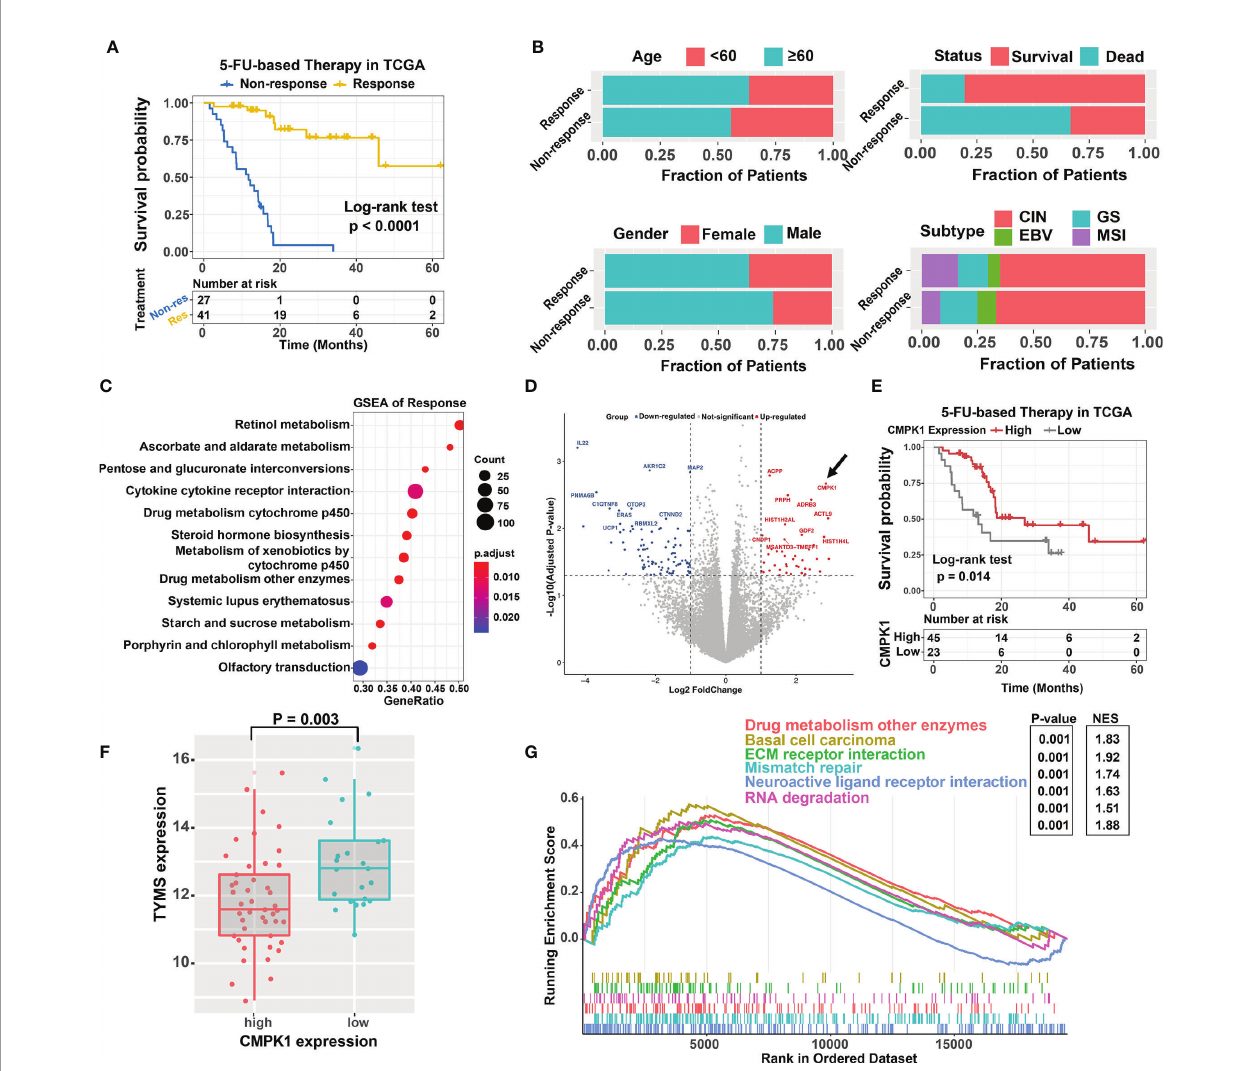
FIGURE 1 | Identi fi cation of the CMPK1 affect the 5-FU chemosensitivity. (A) Kaplan-Meier survival curves of progression-free survival (PFS) for 68 GC patients with 5-FU-based-chemotherapy response (yellow line) or non-response (blue line). (B) Association of clinical features (age, gender, survival status, molecular subtype) and treatment response in GC samples. (C) Dysregulation of signaling pathways strati fi ed by response versus non-response subtypes. (D) volcano plot of the differentially expressed genes in different treatment response subtypes. Blue and red dot indicated the genes highly expressed in non-response and response subgroups, respectively. (E) Kaplan-Meier survival analysis of PFS based on CMPK1 expression subgroups. The samples with upper two thirds CMPK1 expression were termed as high expression, the remaining were termed as low expression. (F) Distribution of TYMS in CMPK1 high versus low expression subgroup (G) Top enriched gene pathways in distinct CMPK1 expression subgroups (high vs low) were assessed by using the GSEA